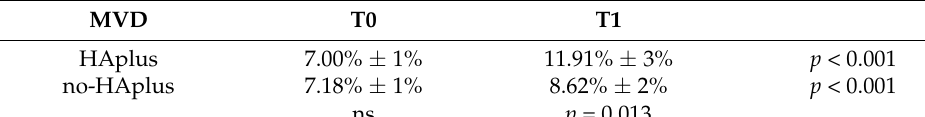
Figure 2. Gingiva: ( A – C ) Sections demonstrate the integrity and normal stratification of the epithelium at the healing site. Pluri-stratified squamous epithelium with ortho- and para-keratinization is depicted in pink and indicated with yellow asterisks, while basal (light blue arrows) to granular layers (white arrows) of epithelium are shown in purple. Carazzi’s H&E, total magnification 200×. ( D – F ) Sections stained with CD31 in brown demonstrate differences in microvascular distribution for each group. Immunostaining anti-CD31, total magnification 200×. ( G – I ) Sections highlighted under polarized light showing the orientation and distribution of collagen fibers in red. More evident collagen bundles are indicated with yellow arrows. Sirius red/Picric Acid, total magnification 200×.